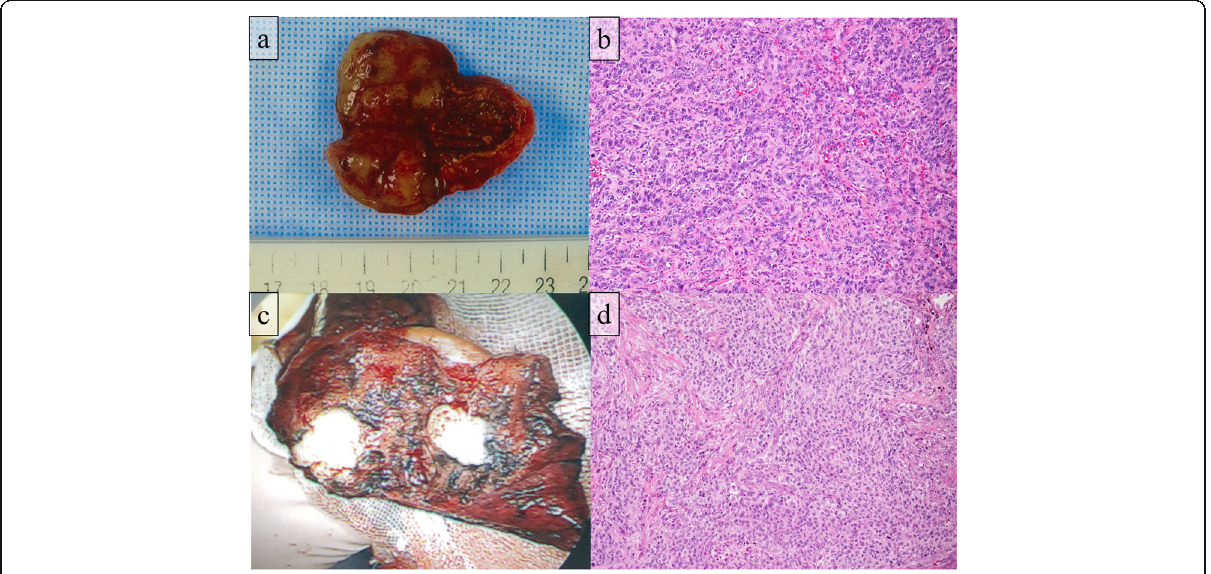
Fig. 2 Pathological findings. a Macroscopic findings of the adrenal tumor: the tumor was a 3.5-cm gray-white tumor with a clear border. b Microscopic findings of the adrenal tumor: the tumor consisted of solid, proliferative, short, spindle cells without clear differentiation. c Macroscopic findings of the lung tumor: the tumor was a 1.4-cm, solid, white tumor with a clear border. d Microscopic findings of the lung tumor: there was no clear keratinization, inter-tissue bridge, or ductal structure, and the findings were similar to those of adrenal